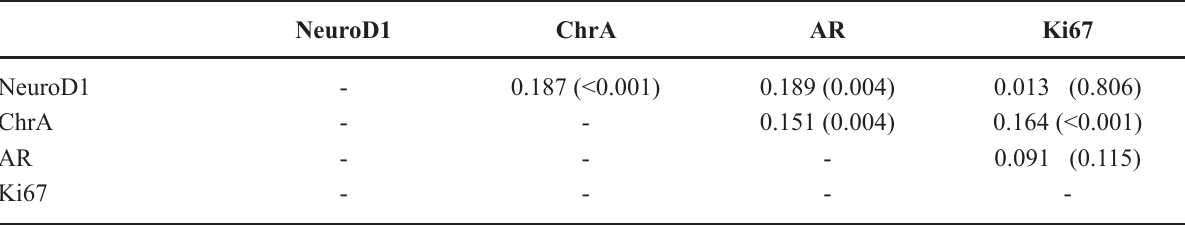
* tables entries are correlation coefficients and p Values. ChrA = chromogranin-A; AR = androgen receptor; Ki6 7= Ki67 label in-